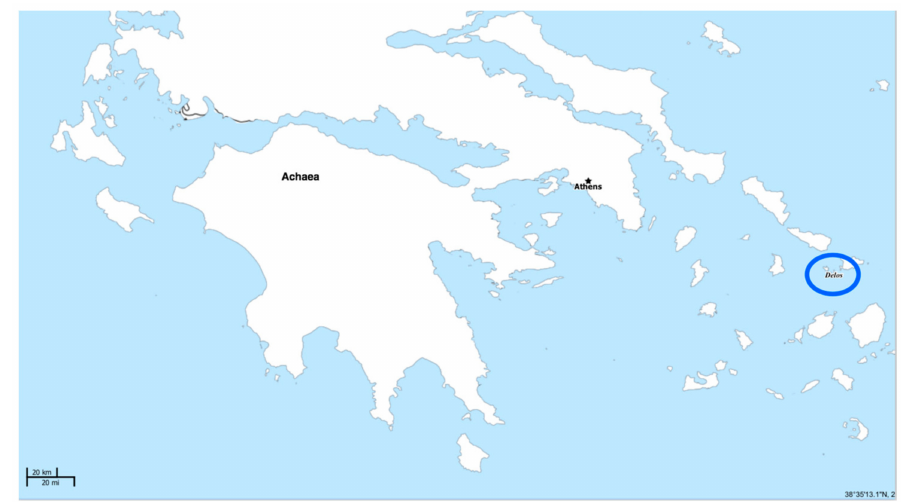
Figure 1. Map of mainland Greece and Cycladic islands. Map Citation: Ancient World Mapping Center. “ À -la-carte”. (http://awmc.unc.edu/awmc/applications/alacarte/) (Accessed: 26 July